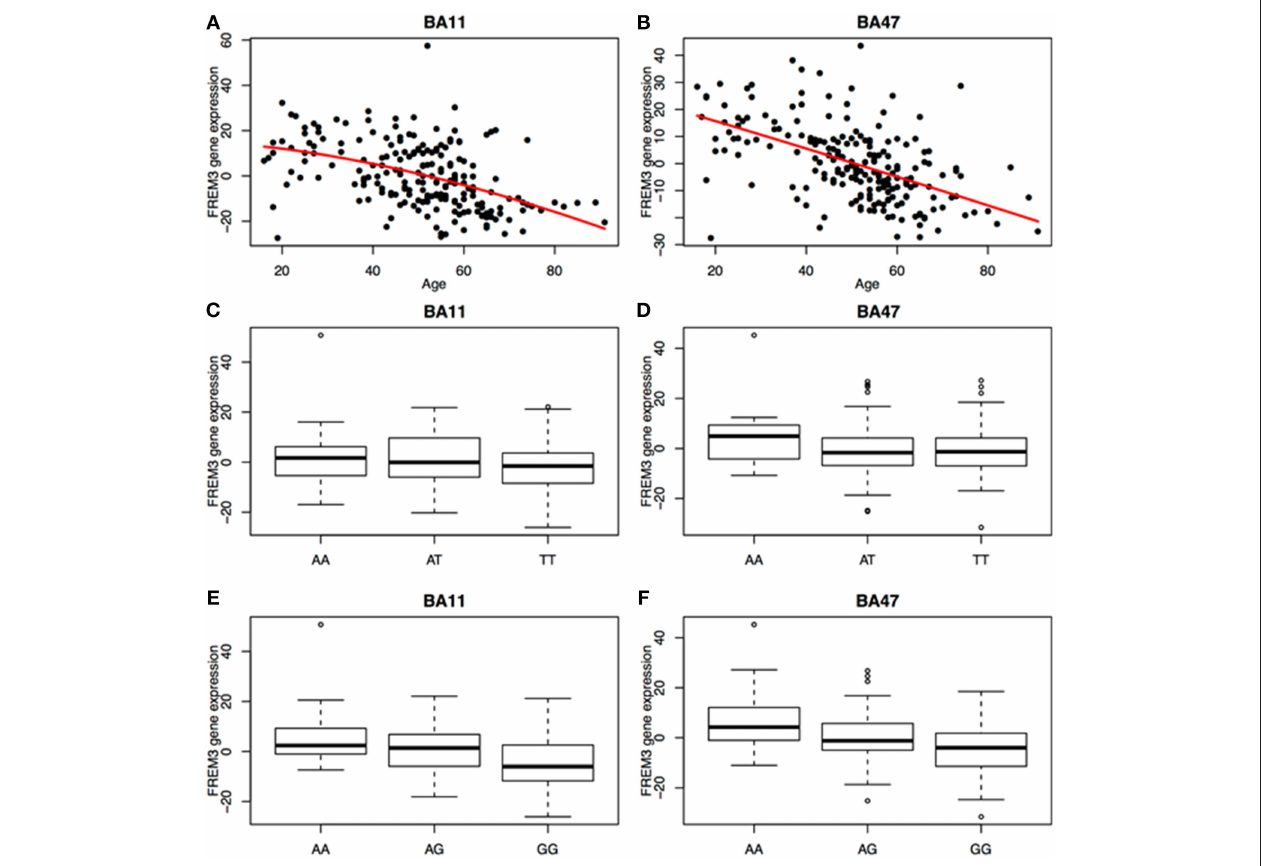
FIGURE 5 | Age was associated with a robust decrease in FREM3 gene expression in both BA11 (A) and BA47 (B) . In addition, the major T allele of rs6537170 (proxy for rs7676614), was associated with trend-level reductions in gene expression in BA11 (C) and BA47 (D) . Finally, the major G allele of rs1391187 was also associated with decreased gene expression in BA11 (E) and BA47 (F) . Each box in (C–F) represents the interquartile range of the data and the whiskers extend to the most extreme data point which is no more than 1.5 times the interquartile range from the